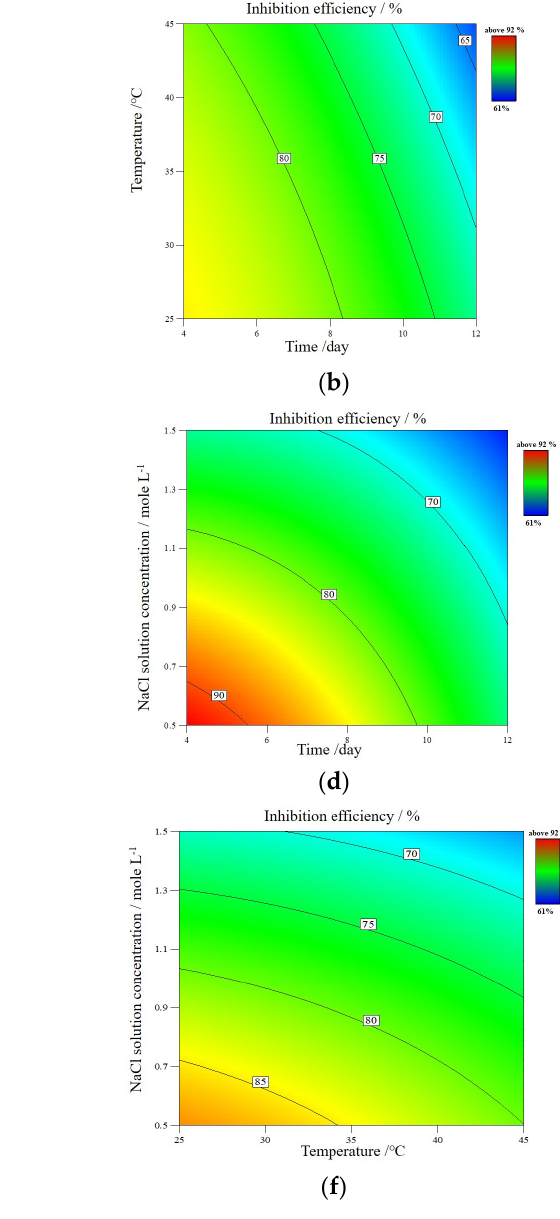
Figure 7. ( a , c , e ) The 3D surface plots and ( b , d , f ) 2D surface plots of the inhibition efficiency, ηω %, response of PVA/PANI/GO-COOH nanocomposite coating over the cast iron surface. According to the model’s calculations, the numerical relationship between the inde- pendent variable and the responses Y (inhibition efficiency) is as follows: